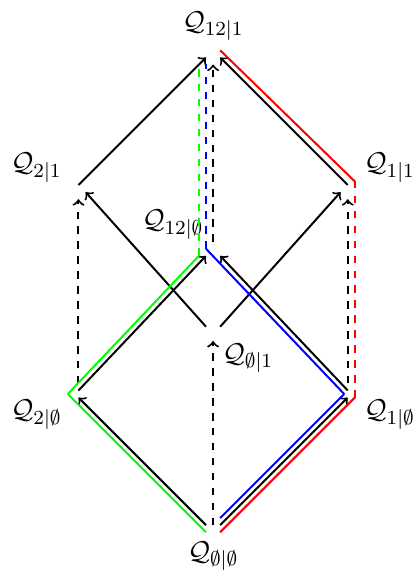
Figure 2 . The Hasse diagram of SU(2 | 1) . Each path from the bottom to the top node corresponds to a particular form of the Bethe equations. The blue path turns into the red path under a fermionic duality transformation and into the green path under a bosonic duality